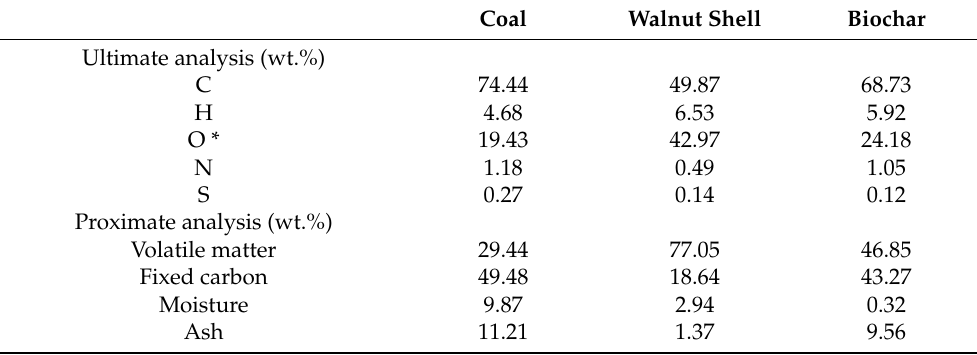
Table 1. Ultimate and proximate analysis of